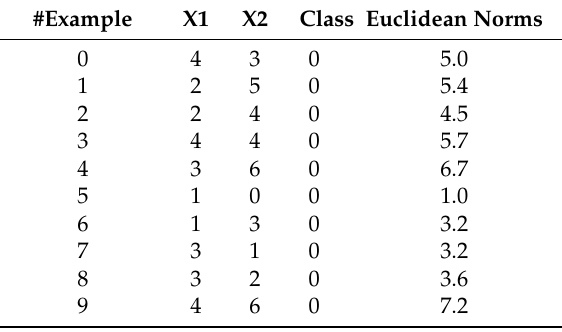
Table 1. A hypothetical training data sample to exemplify the resultant BST of the FPBST, as well as the decision trees of the proposed